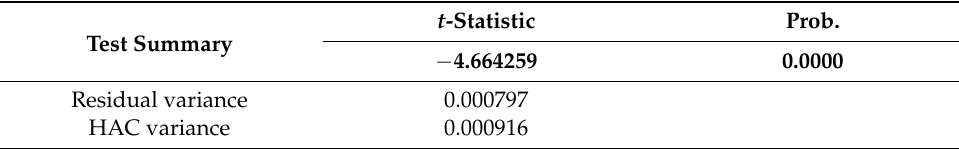
Table 10. Kao residual cointegration test results.